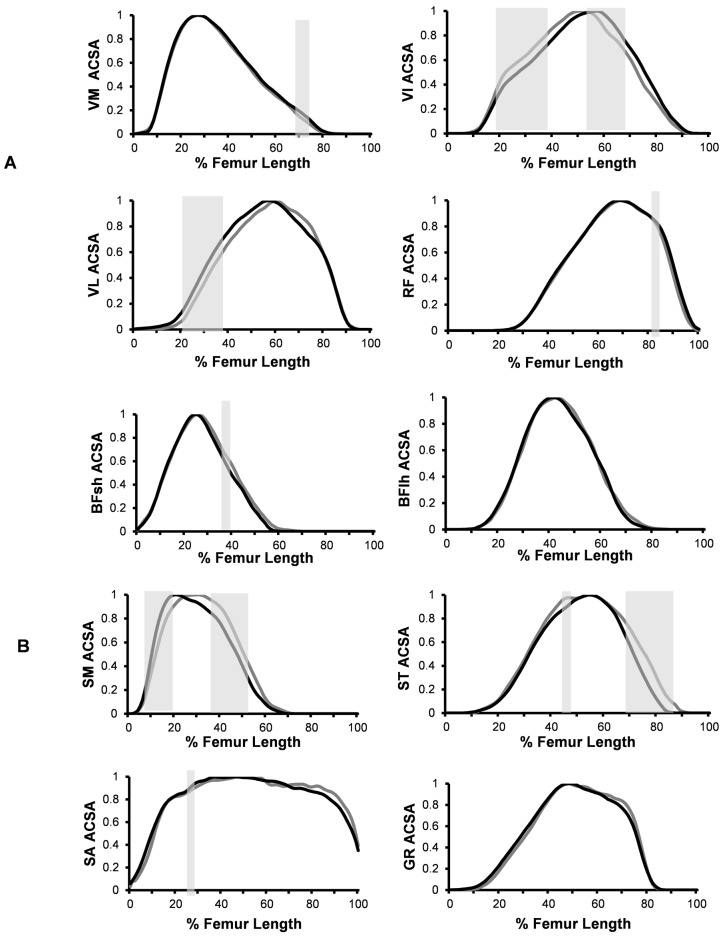
Muscle mass distribution of males (n = 32 black line) and females (n = 34 dark grey line).Mean normalised ACSA (%ACSAmax) of the individual knee extensors (A) and knee flexors (B) along the length of the femur (distal: 0% to proximal:100%). Areas of significant sex differences are shown by light grey shading (P<0.05).